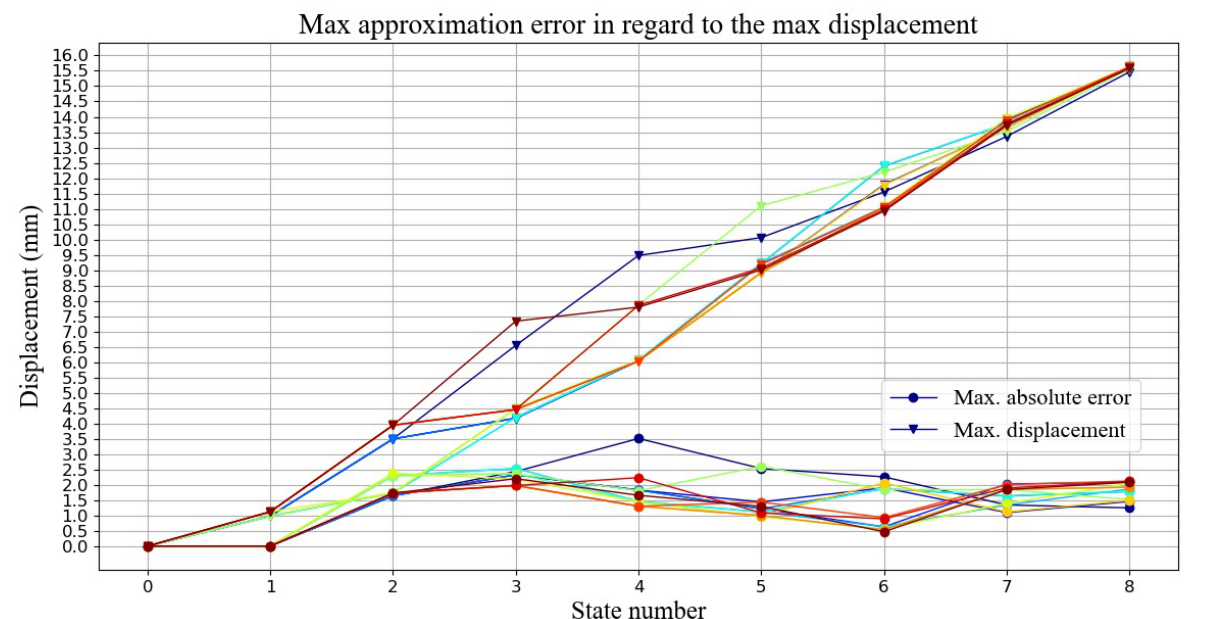
Figure 13. Maximum prediction error and maximum displacement for the MLP regression without topology clustering.